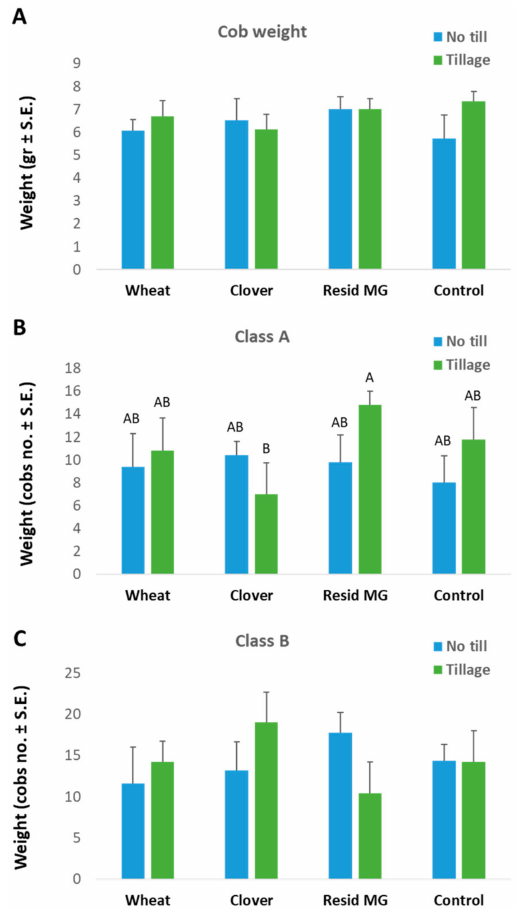
Figure 7. Yield assessment of the field experiments. The evaluation was carried out 80 DAS (25 DAF) and included the total cobs’ average weight in each treatment ( A ), A-class yield—the number of cobs with a weight exceeding 250 g ( B ), and B-class yield— the number of cobs with a weight below 250 g ( C ). Values indicate an average of five replications (each experiment repetition sample included all cobs in the area (15-37 cobs per repeat), so a total of 105-138 cobs were collected for each treatment). Error bars indicate standard error. Statistically significant differences (one-way ANOVA, p < 0.05) between treatments at the same measures (if they exist) are indicated by different letters (A,